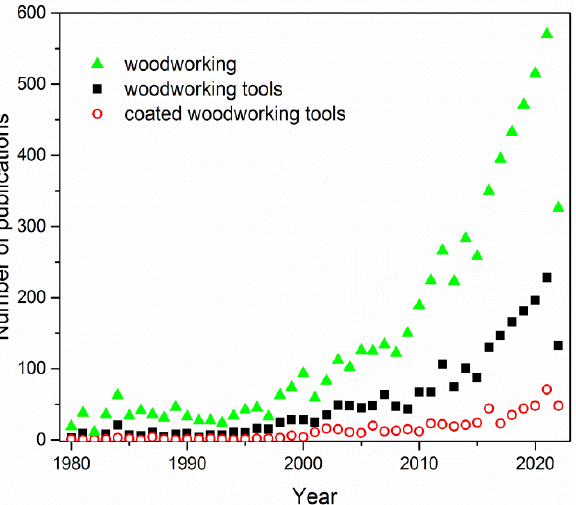
Figure 1. The subject of woodworking and woodworking tools in scientific articles, 1980–2022.